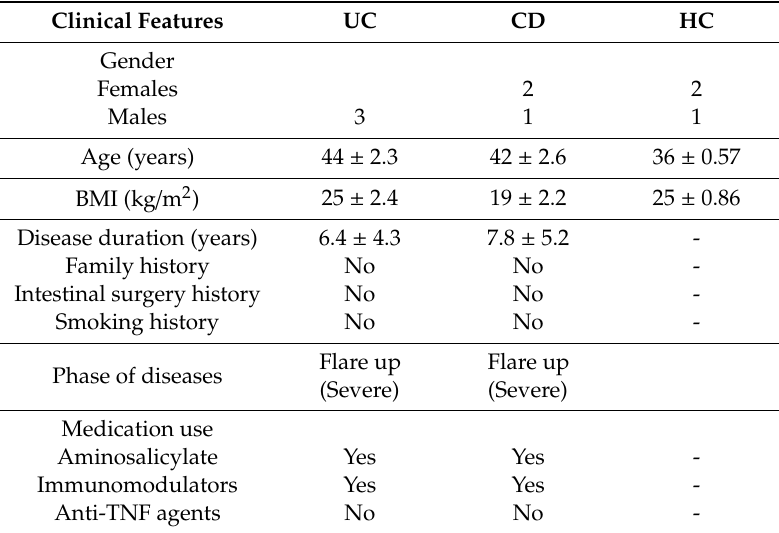
Table 1. Demographics and clinical characteristics of study